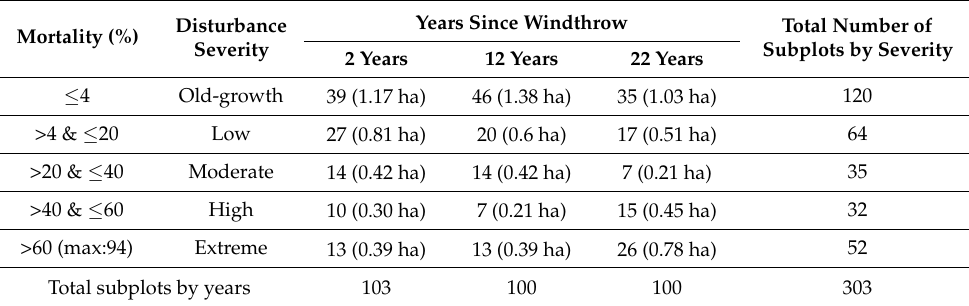
Table 2. The number of subplots and their total area (ha) for each windthrow tree-mortality category (defined as % of individuals) and disturbance severity class. Subplot data are given across the three study sites and periods of time (year) since